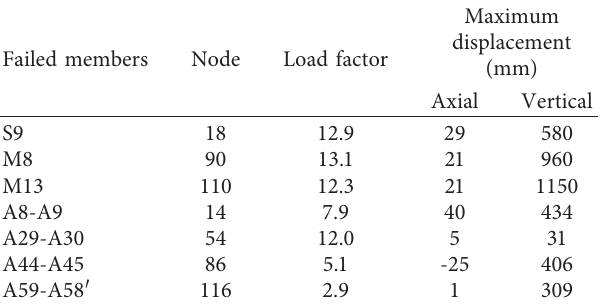
Figure 20: Collapse patterns of the bridge in different cable loss scenarios: (a) loss of cable S9; (b) loss of cable M8; (c) loss of cable M13. Table 5: The collapse performance of the bridge in the cable loss